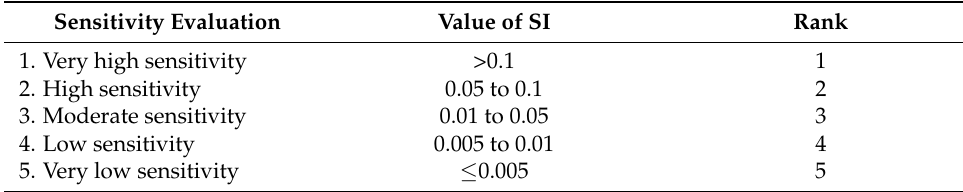
Table 7. Evaluation stander of sensitivity and associated